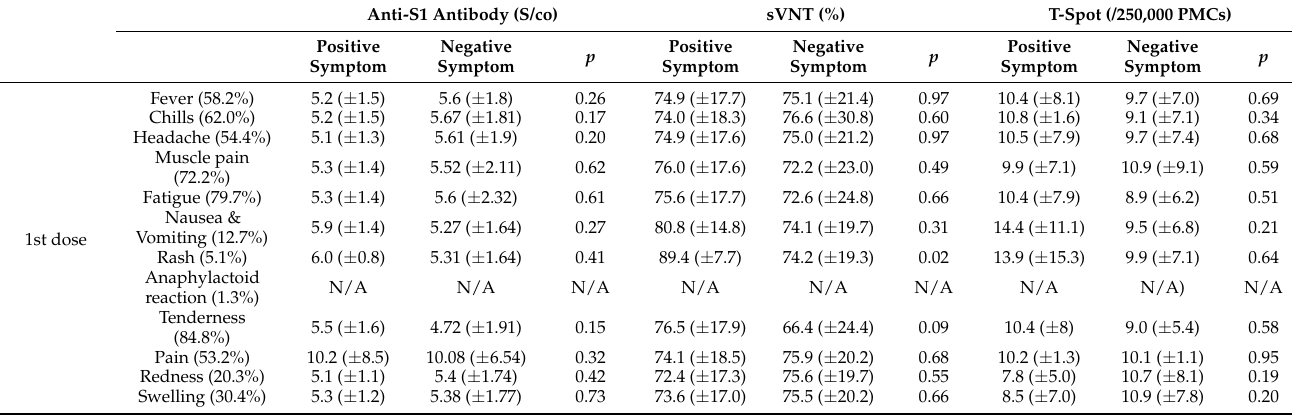
Table A1. The association between immunogenicity and experienced type of adverse event according to first and second dose. Anti-S1 Antibody (S/co) sVNT (%) Positive